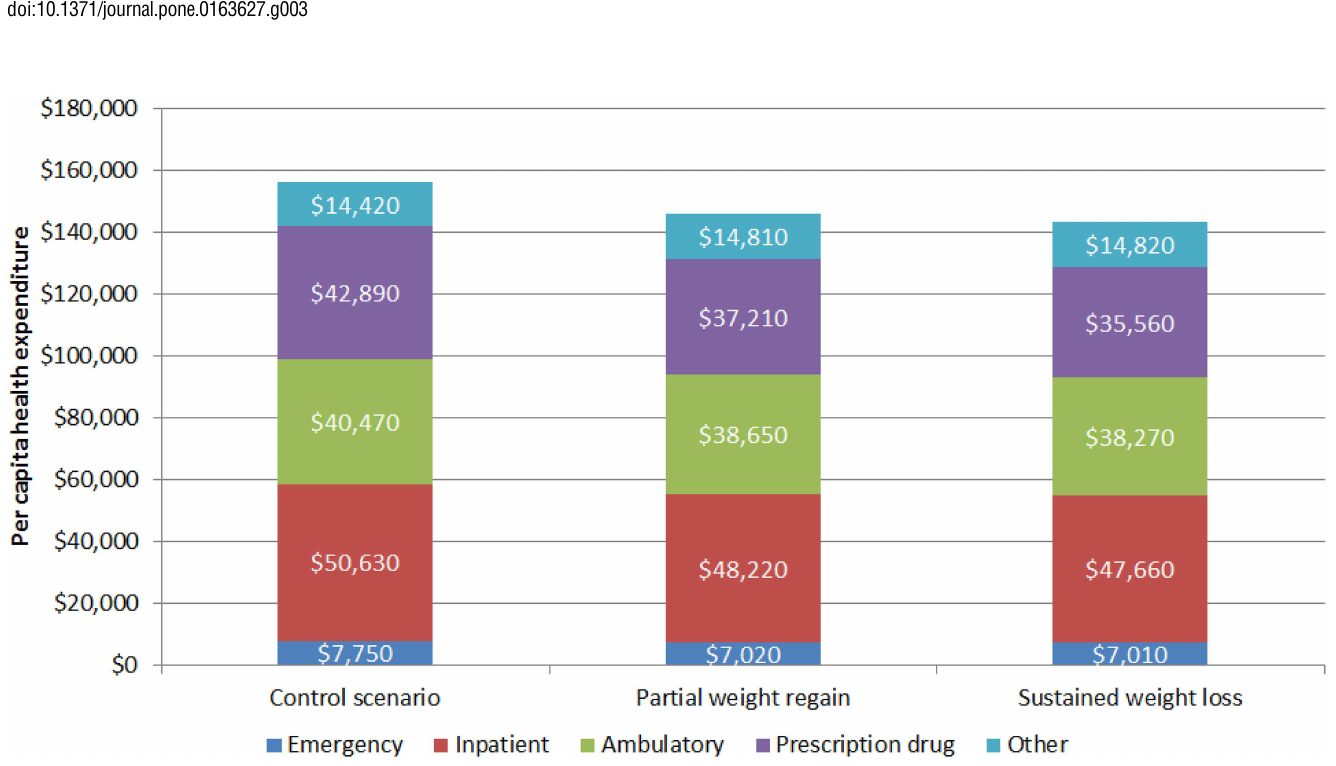
Fig 3. Projected Average Return On Investment of CVD Risk Factor Population On Digital Intensive Behavioral Counseling Program Participation.